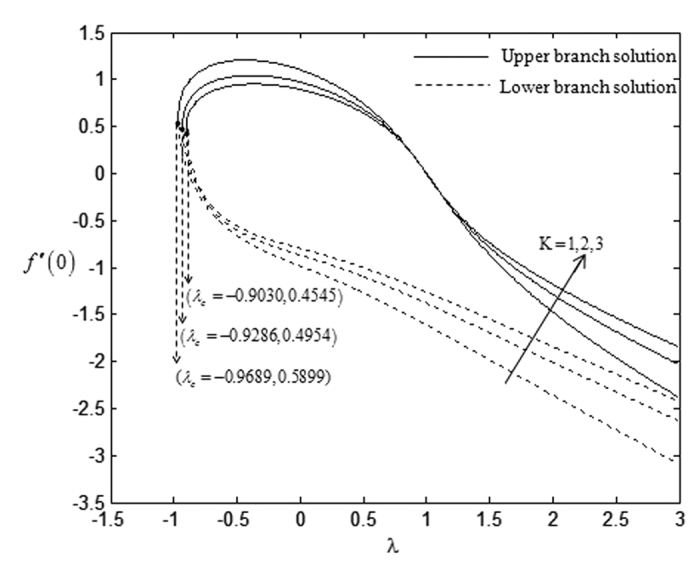
Variations of f ″(0) with λ for some values of K when β = −1 and s = 1.